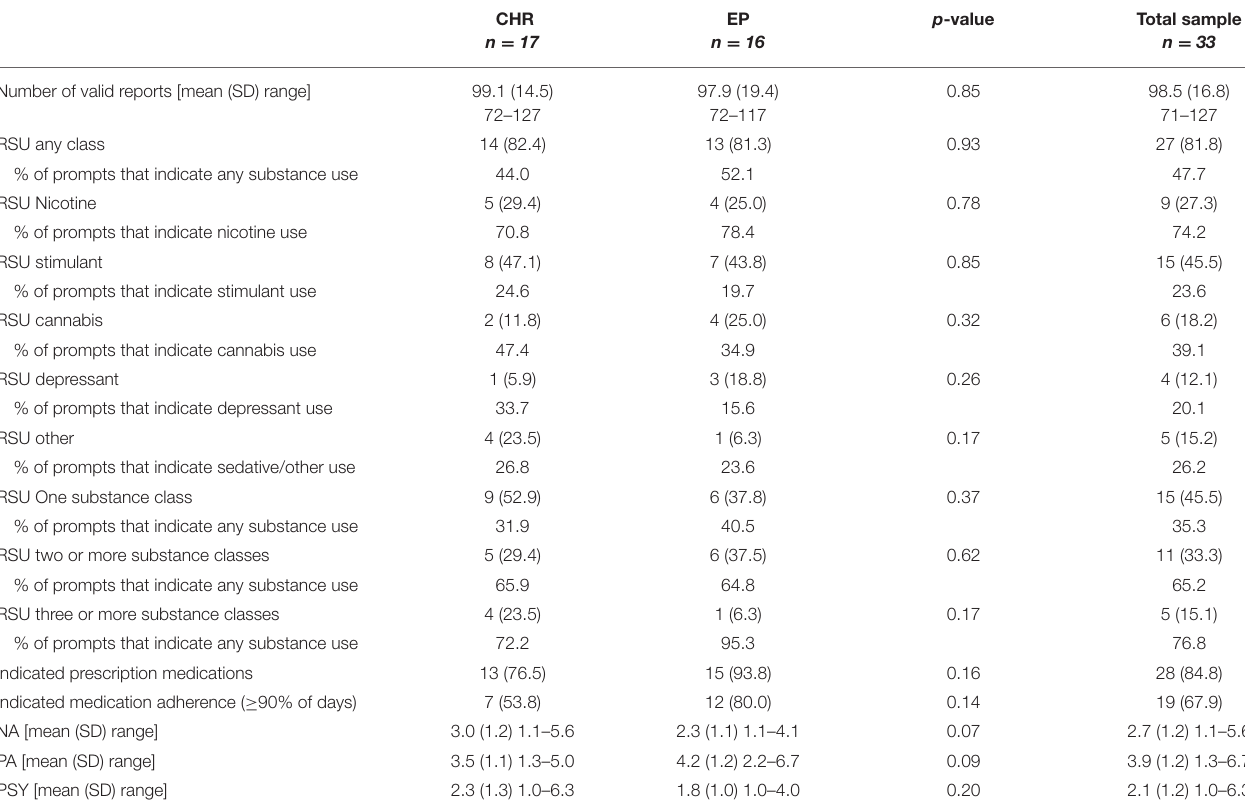
TABLE 2 | Rate of recurrent substance use with experience sampling data characteristics by CHR and EP groups with N (%) reported unless otherwise noted.